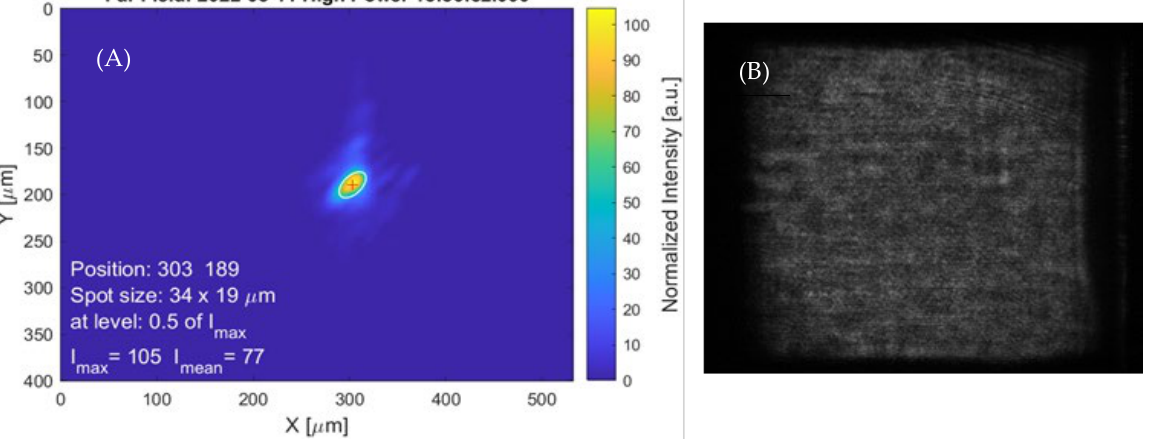
Figure 10. Processed far-field image measured at high power on the BDS table ( A ) and corresponding raw near-field image ( B ) of the L3 laser beam .